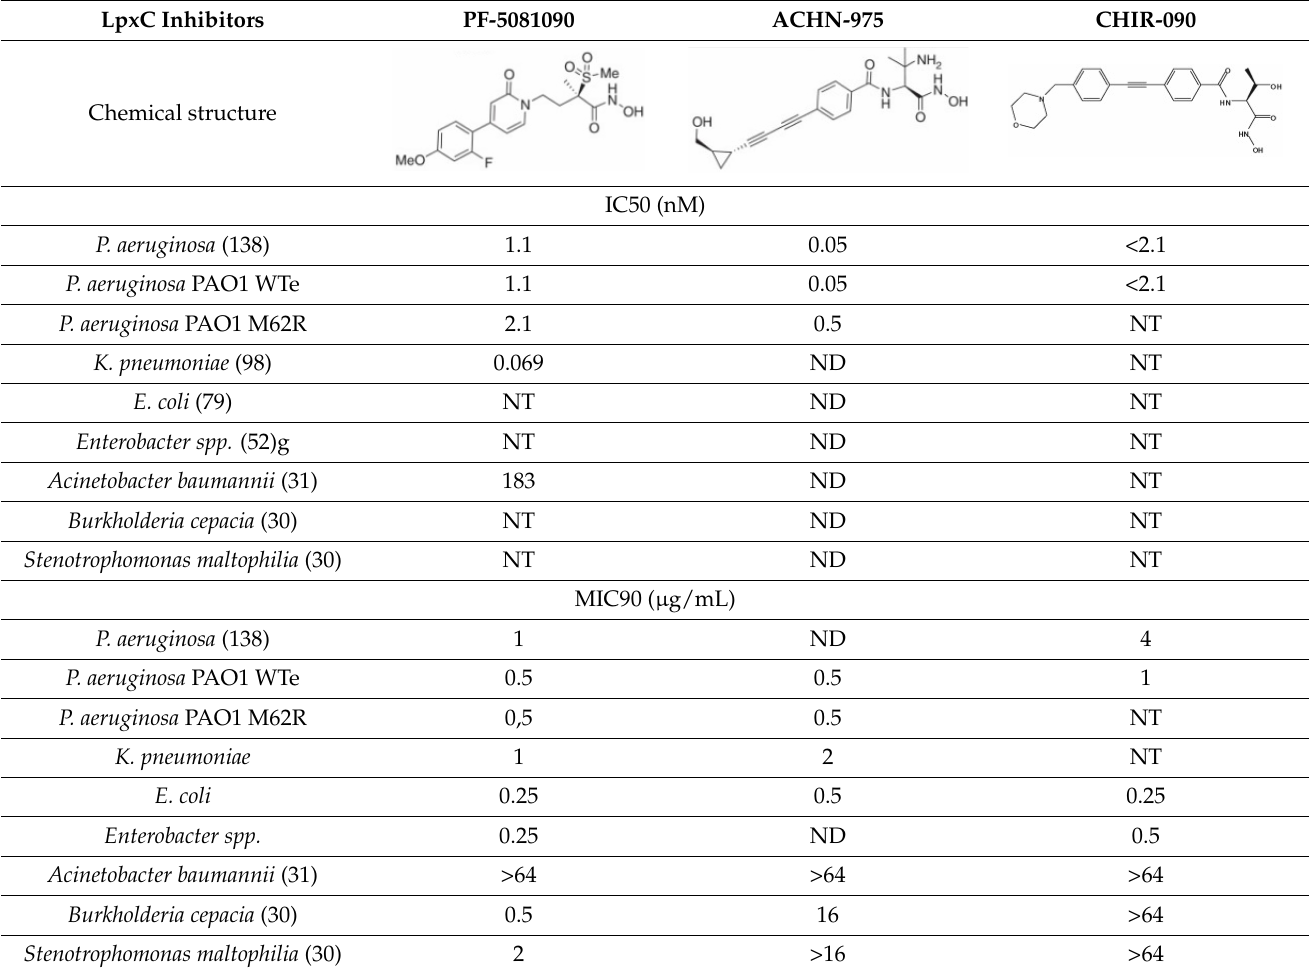
Table 1. Microbiological assessment of activity of the novel LpxC inhibitors in vitro. This table was created based on CHIR-090 and LpxC-4 information from Tomaras et al., (2014) [2], and ACHN-975 information from Krause et al., (2019) [51]. NT: not tested; ND: not determined; IC50: half-maximal inhibitory concentration; MIC90: minimum inhibitory concentration of 90% of